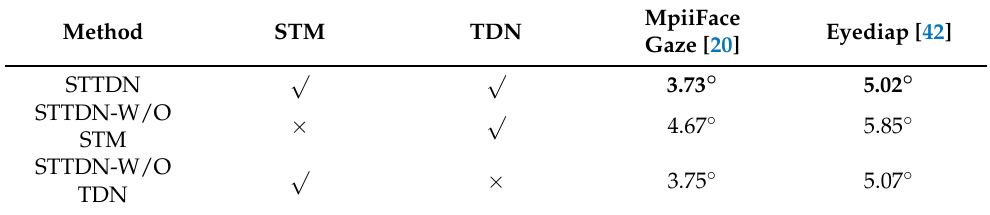
Table 4. Angular errors of STTDN, STTDN-W/O STM, STTDN-W/O TDM on two public datasets: MpiiFaceGaze [20] and Eyediap